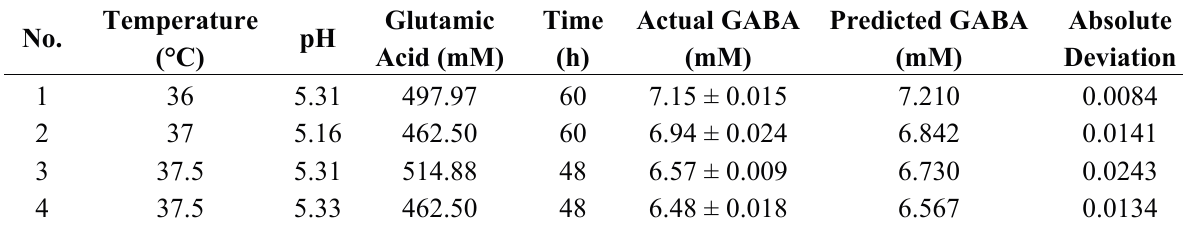
Table 3. Optimum condition